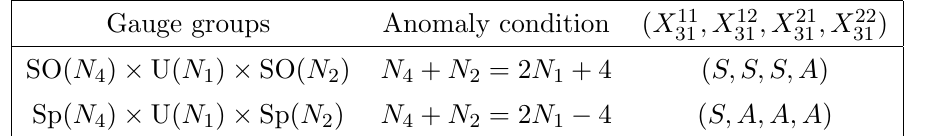
Table 7. The orientifold involution (cid:10) of the magnetic phase of C = Z 0 stands for \Antisymmetric representation", while \S" for \Symmetric